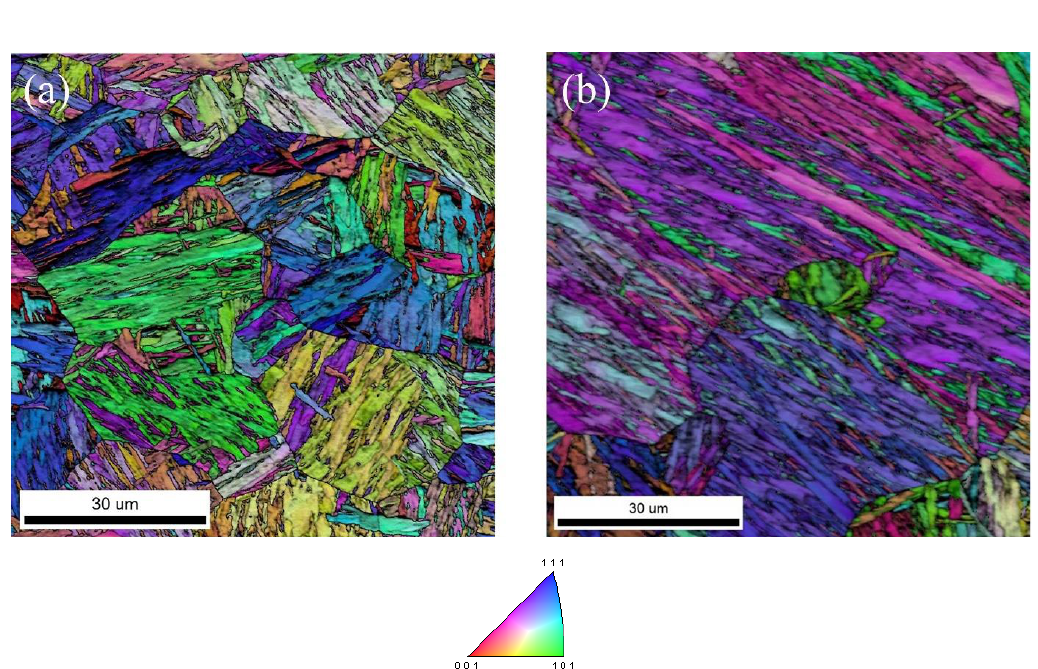
Figure 11. IPF + IQ picture from EBSD analysis of samples: ( a ) S(540, 5); ( b ) S(640, 50).